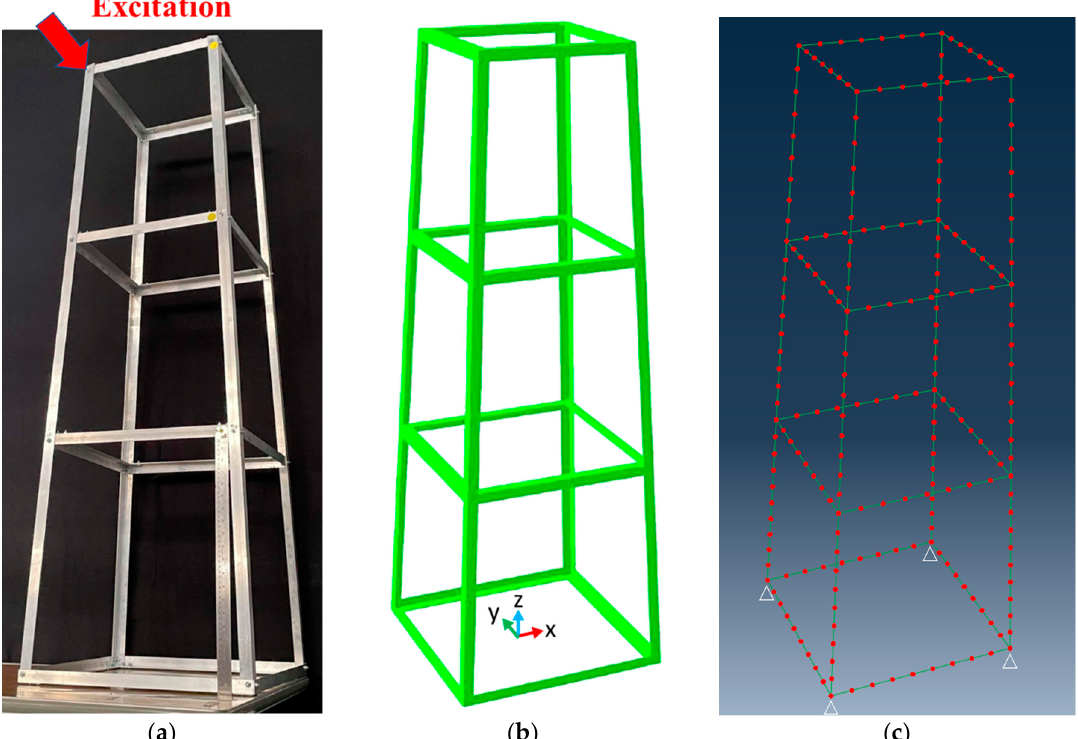
Figure 4. Three-story two-bay experimental frame structure: ( a ) Physical model, ( b ) finite-element model with sectional profile rendering, and ( c ) finite-element mesh with nodes (red dots) and fixed boundary conditions (white triangles).